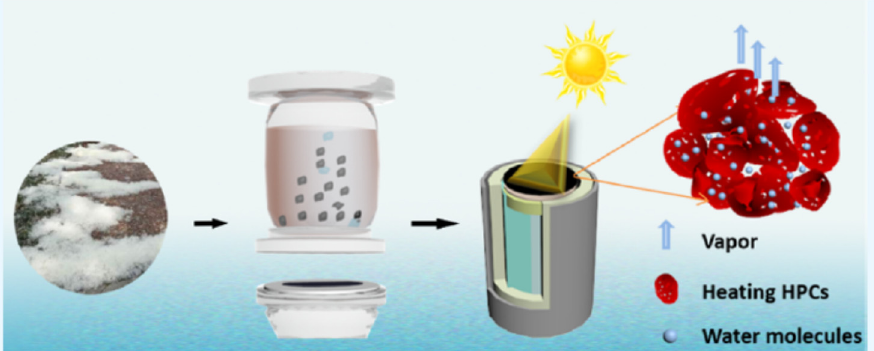
Figure 10. Photo and drawing showing the willow catkin, activated carbon membrane, and the solar steam generator. Reprinted from [20], ©2020 The Authors.